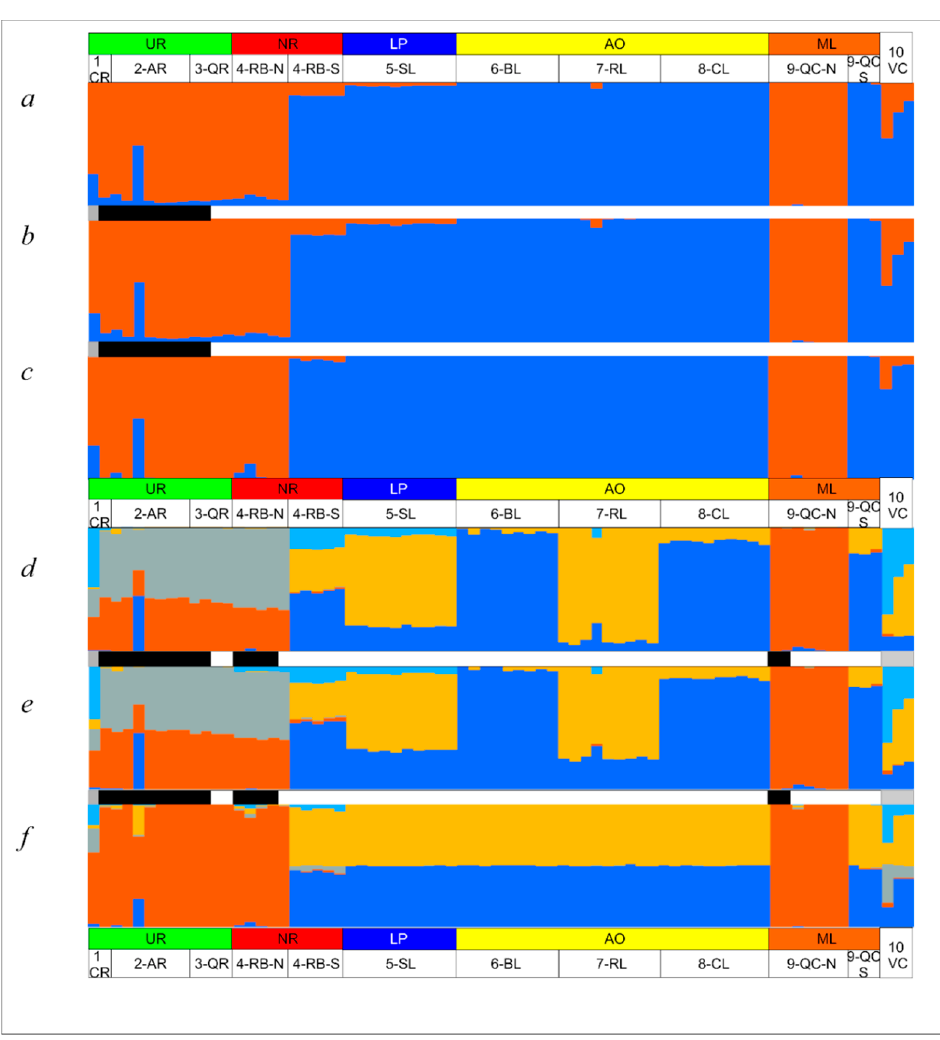
Figure 3. Estimated population structure (K = 2, a – c ; K = 5, d – f ) in STRUCTURE of Rhamdia quelen from the La Plata River basin, the Merin Lagoon and coastal lagoons from SW Atlantic Ocean based on Total 17,559 ( a , d ), Neutral 15,584 ( b , e ) and Outliers 73 ( c , f ) SNP loci. Each bin or colored vertical bar represents the estimated membership fraction of an individual in the major population clusters. Basin abbreviation and color together with sampling sites codes are indicated in Figure 1. Bar among histograms represent the mtDNA lineage of each individual as follows: Rq2 : grey; Rq4 : black; Rq6 : white. Pairwise genetic di ff erentiation results were significant for most comparisons tested (Tables 4–6). Pairwise F ST values were similar between Total and Neutral datasets (Tables 4 and 5). Total, Neutral and Outlier analyses showed high di ff erentiation between locality samples from the Northern (1-UR-CR, 2-UR-AR, 3-UR-QR) and Southern (5-LP-SL, 6-AO-BL, 7-AO-RL, 8-AO-CL) basins in the studied region. However, by contrast to the Total and Neutral analyses (mean F ST : 0.215 and 0.180, respectively), the Outlier dataset did not evidence genetic di ff erentiation among coastal lagoons (F ST : 0.000; Table 6). In addition, much higher F ST values between localities from the North and South Clusters were obtained using Outlier SNPs (mean F ST : 0.939) than when using the Total and Neutral datasets (mean F ST : 0.527 and 0.336, respectively). Mantel test was not significant; hence, it did not support the IBD hypothesis ( p =